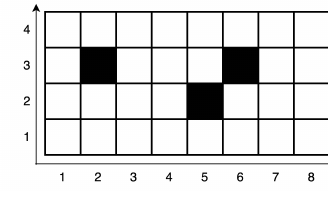
Figure 22. A 8 × 4 grid of cells. Three cells are equal to 1.